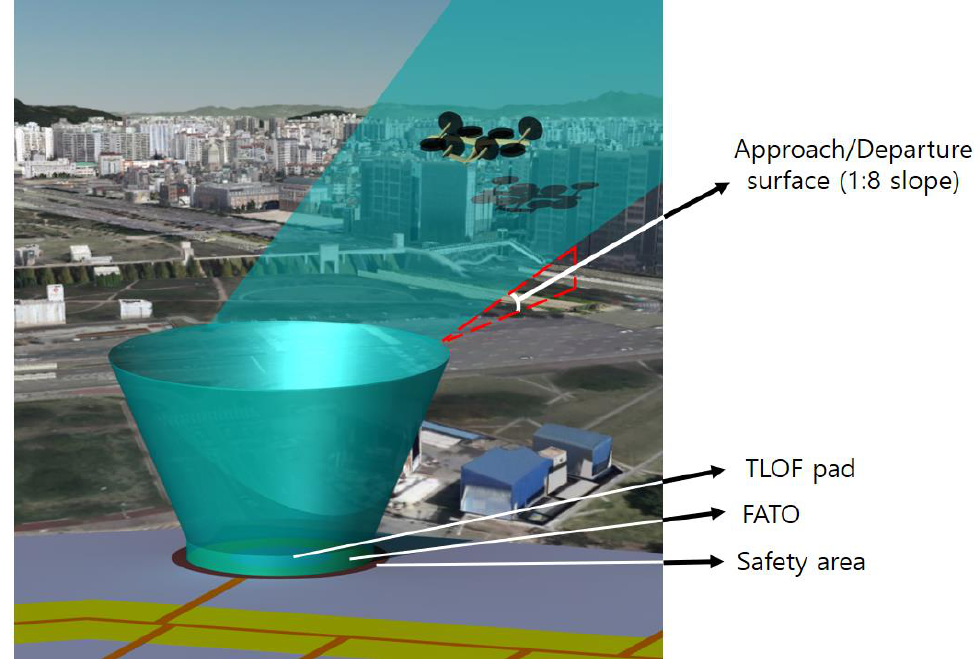
Figure 40. Detail approach/departure surfaces for a pier topology at the current Gimpo Airport parking lot that comply with the EASA’s new regulations. Table 11. The dimensions of the approach/departure surface for the pier topology at the current Gimpo Airport parking lot that comply with the EASA’s new regulations.